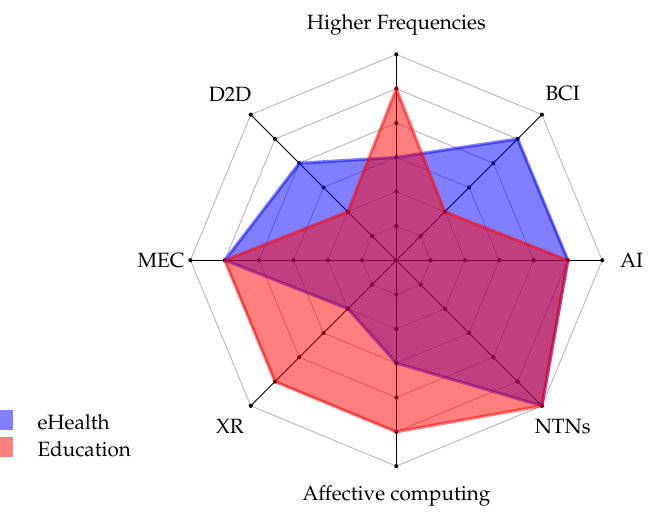
Figure 4. Relevance of the 6G technologies on the two use cases.